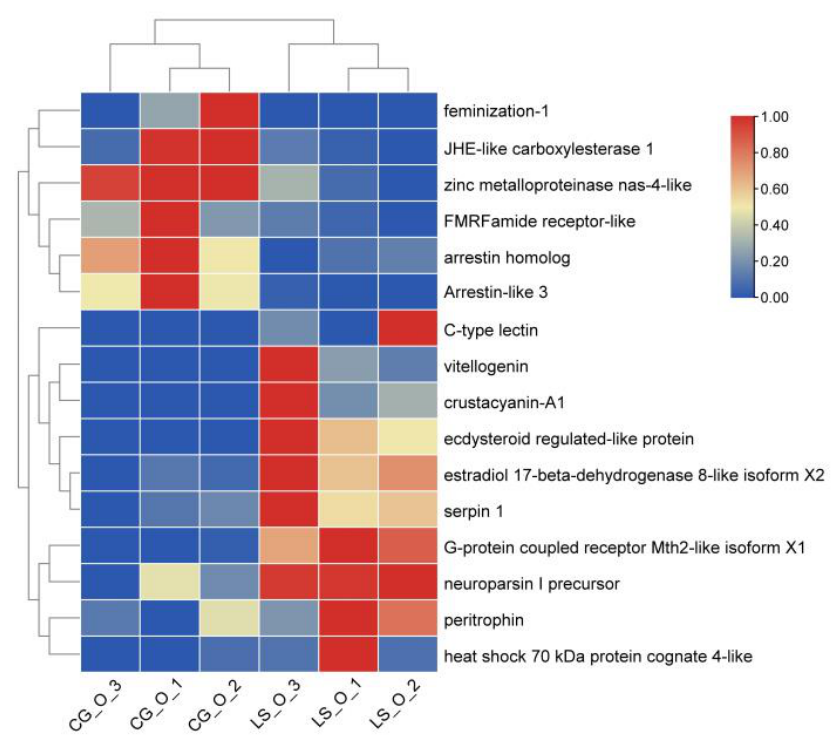
Figure 6. The heatmap of DEGs related to ovarian development in the LS _ O vs. CG _ O group. The columns and rows indicate individuals and genes, respectively. The color scale represents FPKM after standard normalization, the same below.